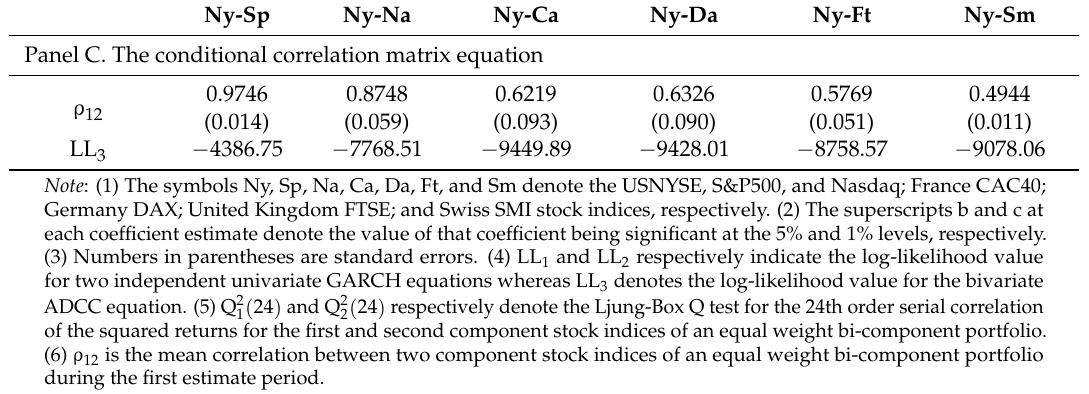
Panel C. The conditional correlation matrix